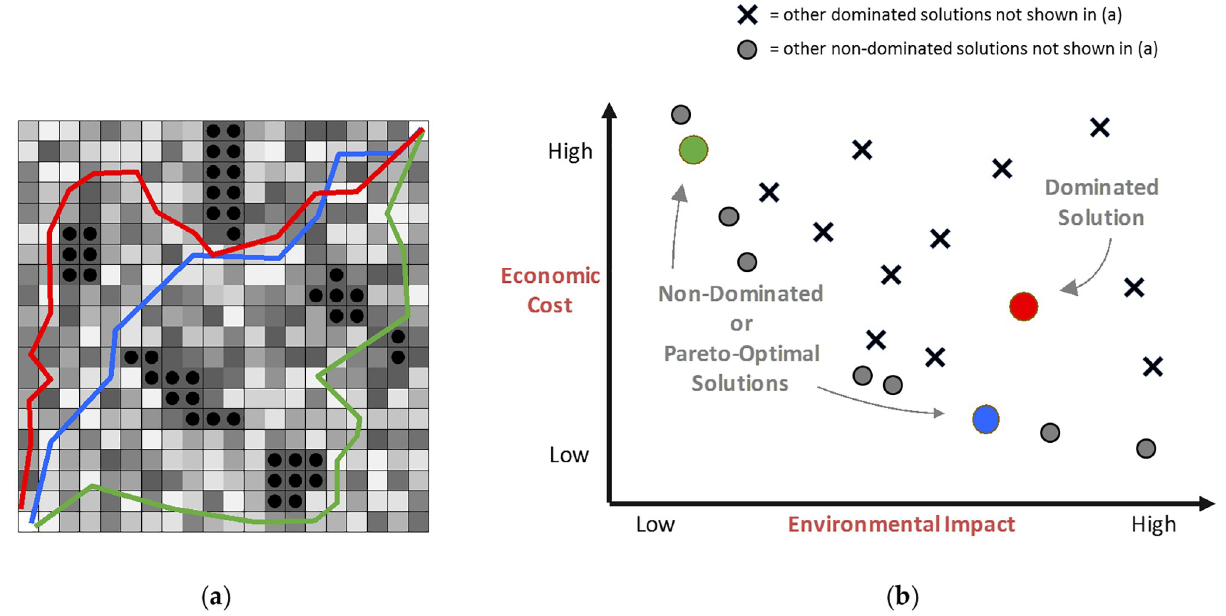
Fig 2. Evaluating three paths in both (a) decision space, and (b) objective